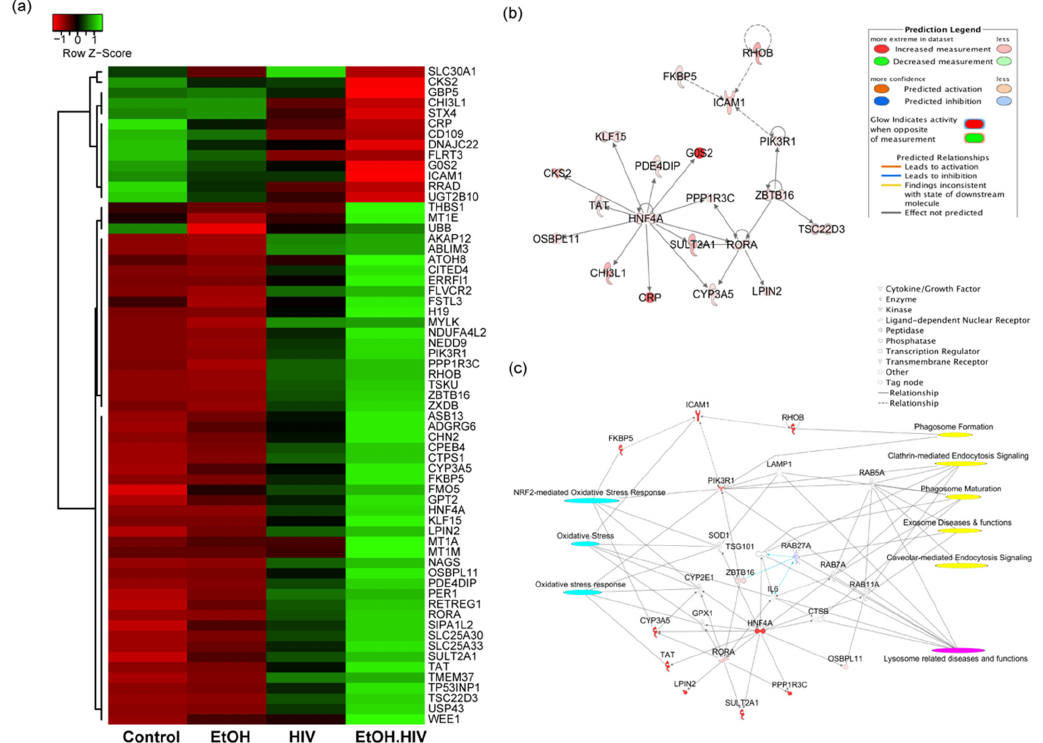
Figure 3. Differentially expressed genes (DEGs) and upstream regulator analysis of primary human hepatocytes and their interaction with target molecules regulating oxidative stress, lysosome related diseases and EVs biogenesis. ( a ) Heat maps and hierarchical clustering-based dendrograms of DEGs from different experimental groups. Expression variability between the groups is indicated by the Z score, where shades of red and green color denote down and upregulation of genes, respectively. ( b ) An integrated network of RORA, ZBTB16, RHOB, HNF4a, and FKBP5 upstream regulators and their target genes. All the targets and upstream regulators were differentially regulated in the dataset based on Ingenuity Pathway Analysis (IPA) upstream regulator analysis. For the color code, refer to the prediction legend. ( c ) Interaction of RORA, ZBTB16, RHOB, HNF4a, and FKBP5 with target genes to regulate oxidative stress (cyan), lysosome-related disease, and functions (magenta) and exosome biogenesis (yellow). Different types of interaction molecules are mentioned in the legend.